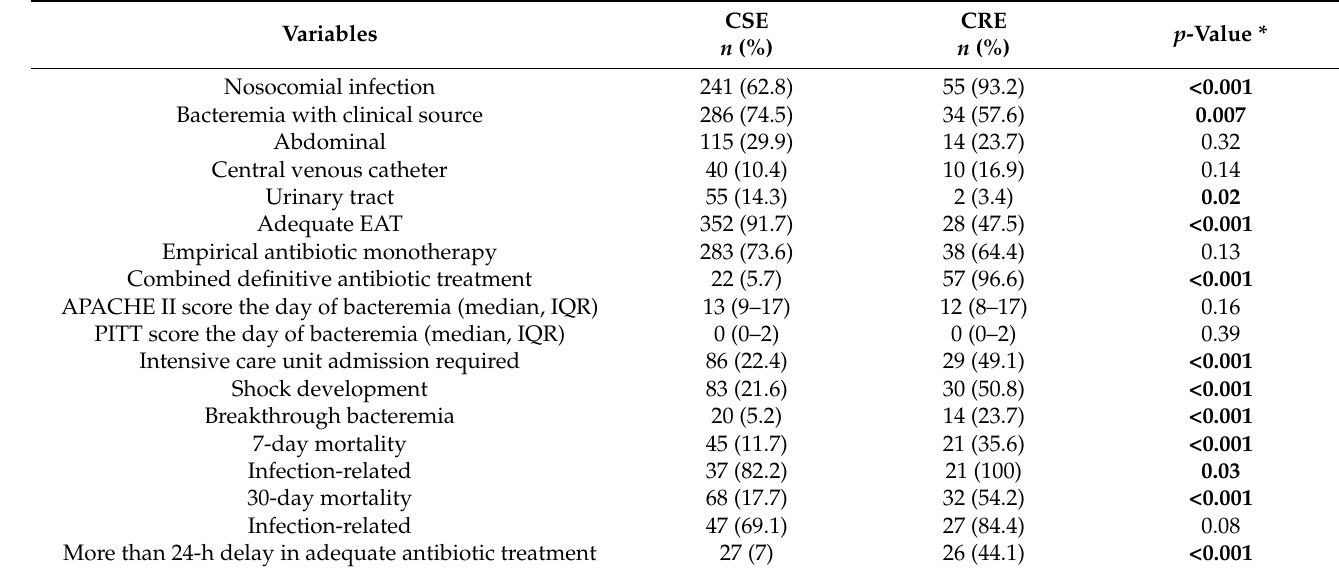
Table 2. Clinical presentation, treatment, and outcome of carbapenem-susceptible Enterobacterales (CSE) and carbapenem-resistant Enterobacterales (CRE)